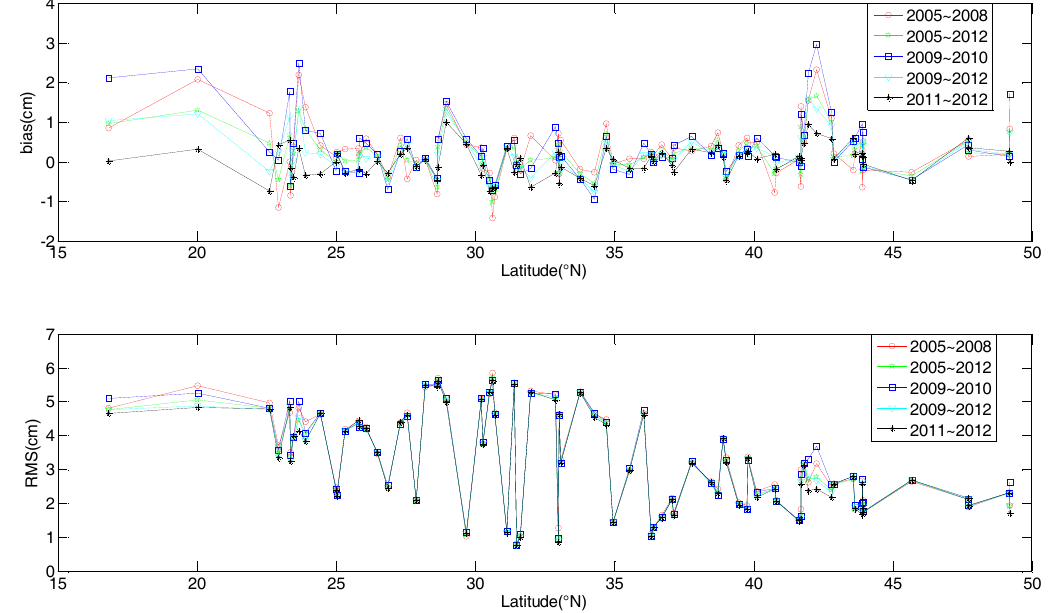
Figure 7. Comparison of the accuracy for the SAAS_S model based on data from different periods in different regions.